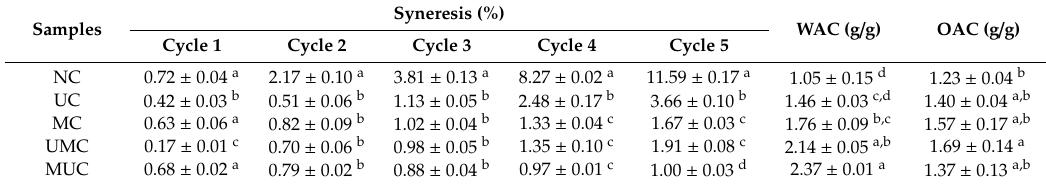
Table 3. Syneresis, water (WAC) and oil (OAC) absorption capacities of native and modified chestnut